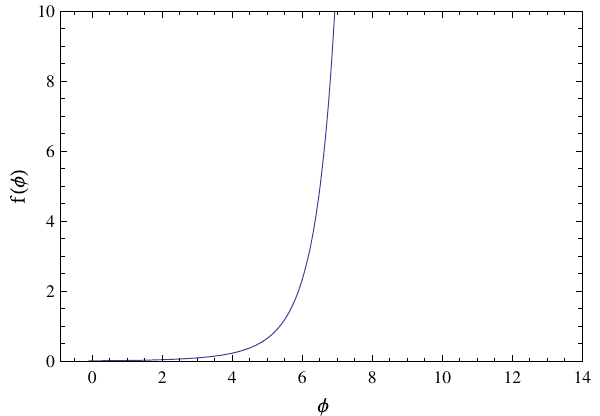
Fig. 23 Variation of f (φ) with the variation of φ for the JBP param- eterization (Model III)